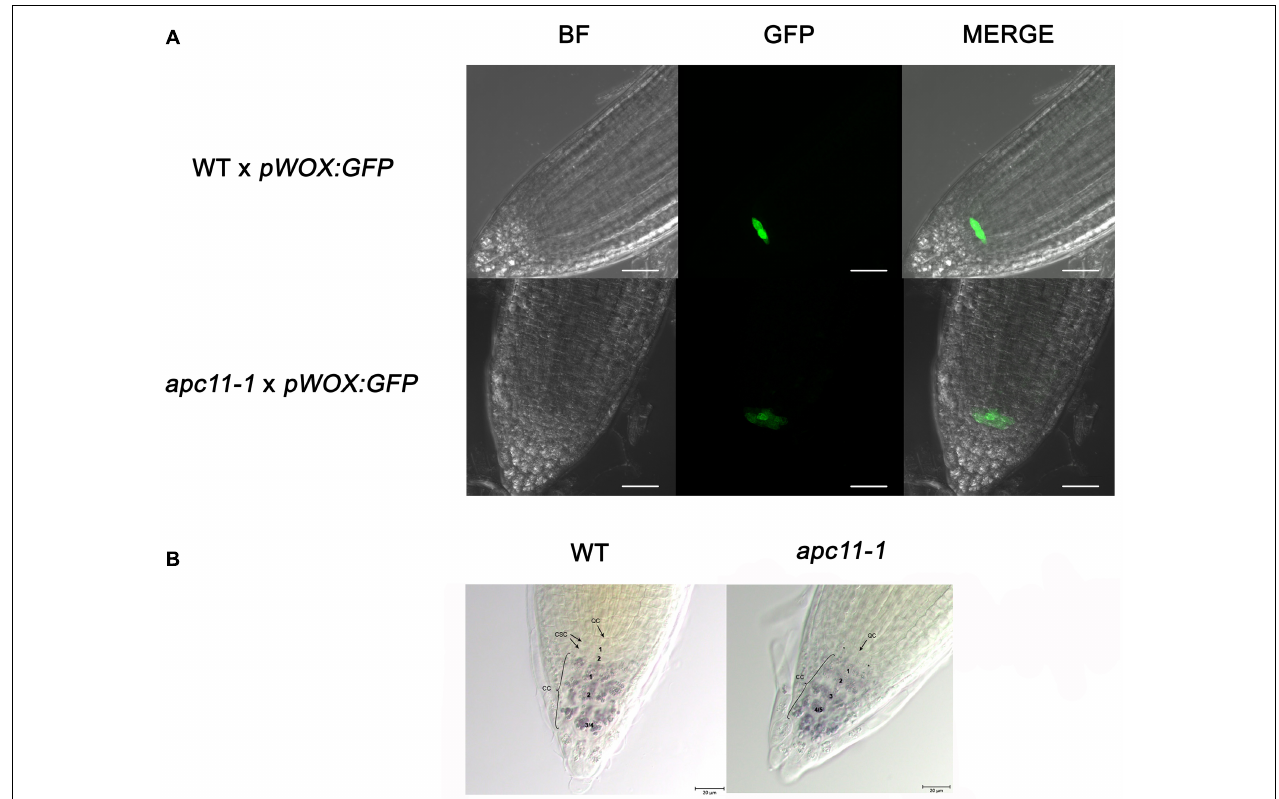
FIGURE 4 | The apc11 . 1 crosses with pWOX5 : erGFP markers show altered quiescent center (QC). Confocal microscopy of the meristematic architecture of 6 DAS roots of mutant ( apc11-1 ) and WT plants crossed with pWOX5:erGFP . The middle panel corresponds to green fluorescent protein (GFP) emission. The left panel corresponds to Bright Field (BF) images, and the right panel corresponds to the merged picture of GFP and BF images. White bar = 30 µ m. (A) WT plants show normal phenotype exhibiting a plane with 4 quiescent cells (QCs), while apc11-1 mutant shows extended expression of the pWOX5:erGFP marker. (B) Representative DIC images of the QC cells in the WT and apc11-1 plants. Lugol’s staining showing the accumulation pattern of starch granules in the columella stem cells (CSCs).* Starch granules indicating the differentiation of CSC. Black bar = 20 µ m, n =